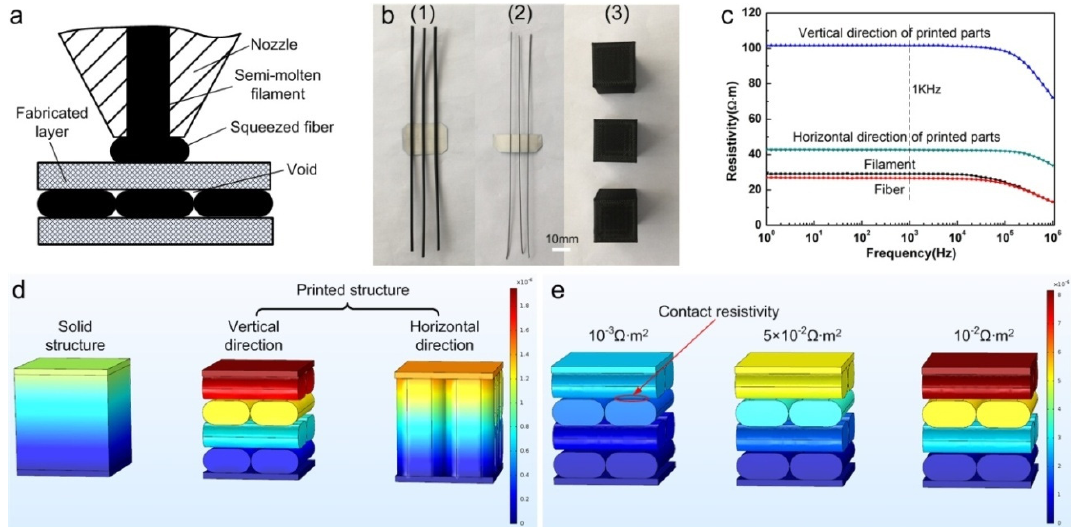
Figure 1. Varied shapes and their resistivities for materials in FDM. ( a ) Process of FDM, the semi-molten fibers weresqueezed and deposited to form parts with the desired shape; ( b ) varied shapes of materials: filament, fiber, and cube; ( c ) resistivities of materials in different shapes and frequencies of 1 Hz–1 MHz; ( d ) resistivities of the models in varied structures and shapes from the simulation, including solid structure, printed structure in the vertical direction, and printed structure in the horizontal direction. In the color bars, the gradient from blue to red means that the potential increases, i.e., the resistivity increases, as the current density is the same for all of models; and ( e ) resistivites of the printed structure modelsin the vertical direction with different contact resistivities between fiber layers.